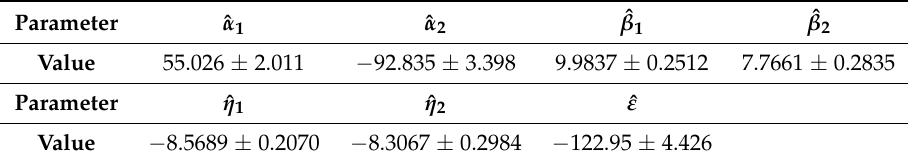
Table 1. Estimated model parameters with their accuracy